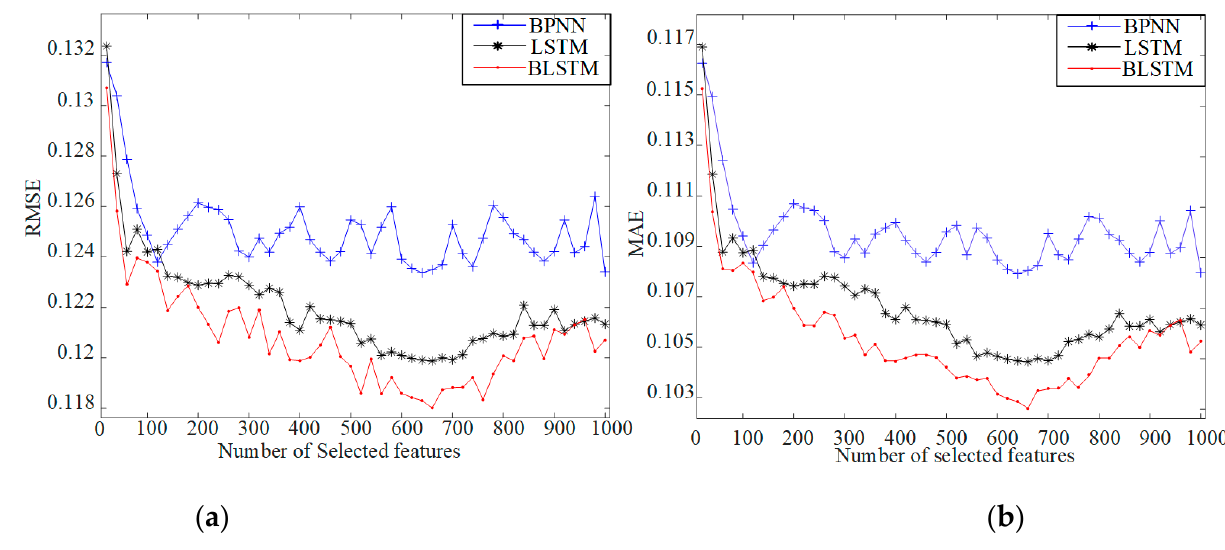
Figure 13. Comparison of the WPP RMSEs of backpropagation neural network (BPNN), LSTM, and BLSTM with the increase in the number of features ( a ) RMSE of WPP changing with the number of input features; ( b ) MAE of WPP changing with the number of input features.